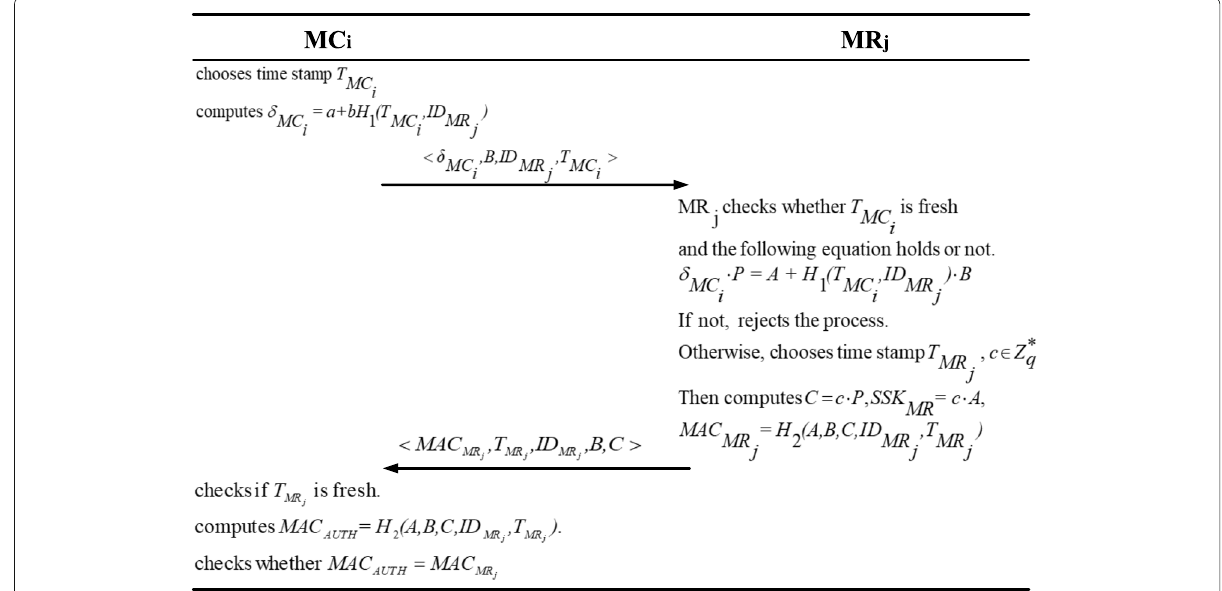
Fig. 3 Handover authentication phase. This figure describes the parameters exchanged in the handover authentication